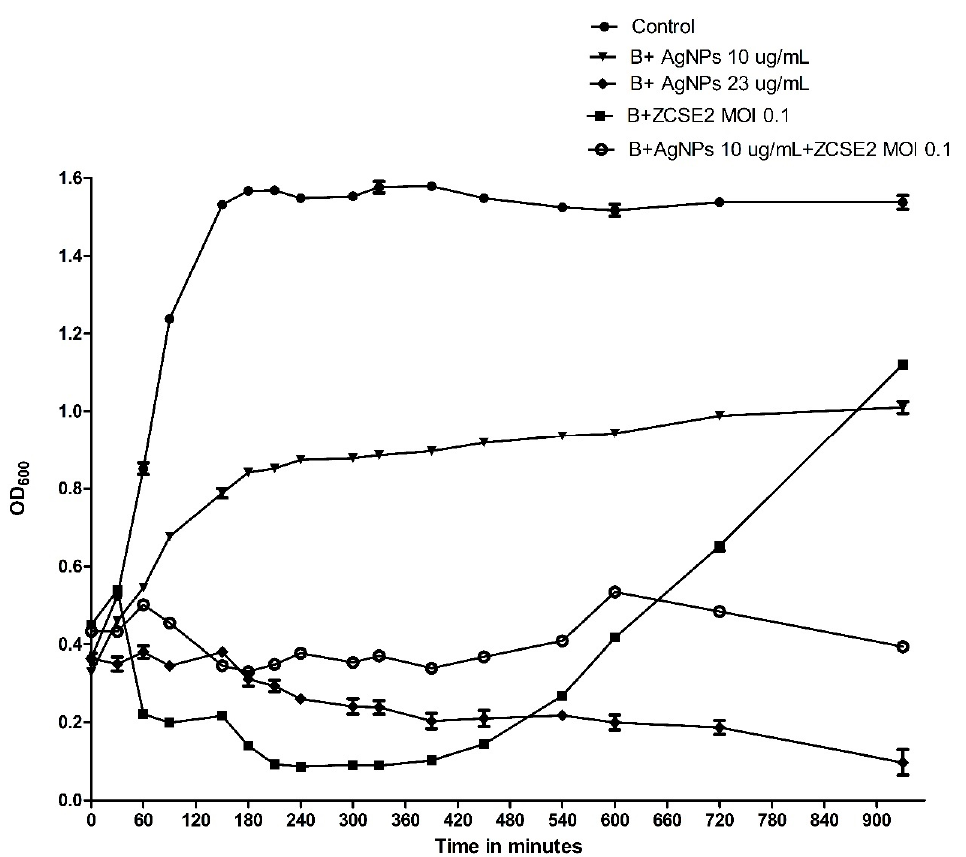
Figure 6. Illustrates the Time-Killing curve of S. Enteritidis WT (Platten) with 1 × MBC of AgNPs, phage MOI 0.1, AgNPs of final concentration of 10 µg/mL, and mixture of AgNPs of final concentration of 10 µg/mL and phage MOI 0.1.